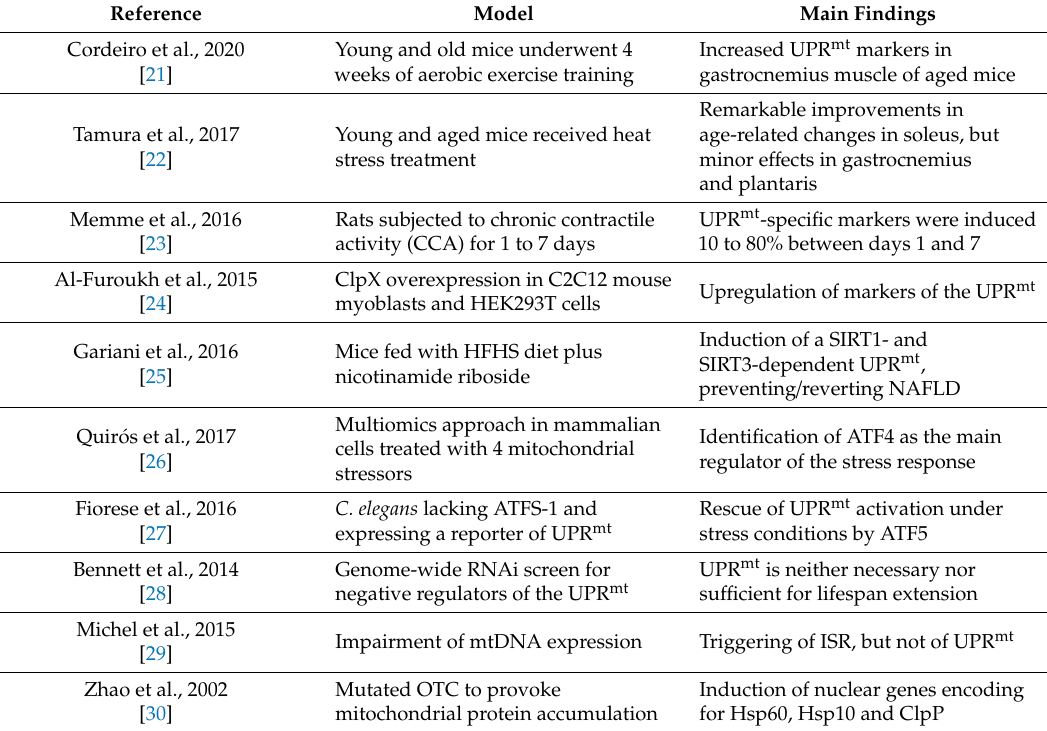
Table 1. UPR mt in the context of skeletal muscle and